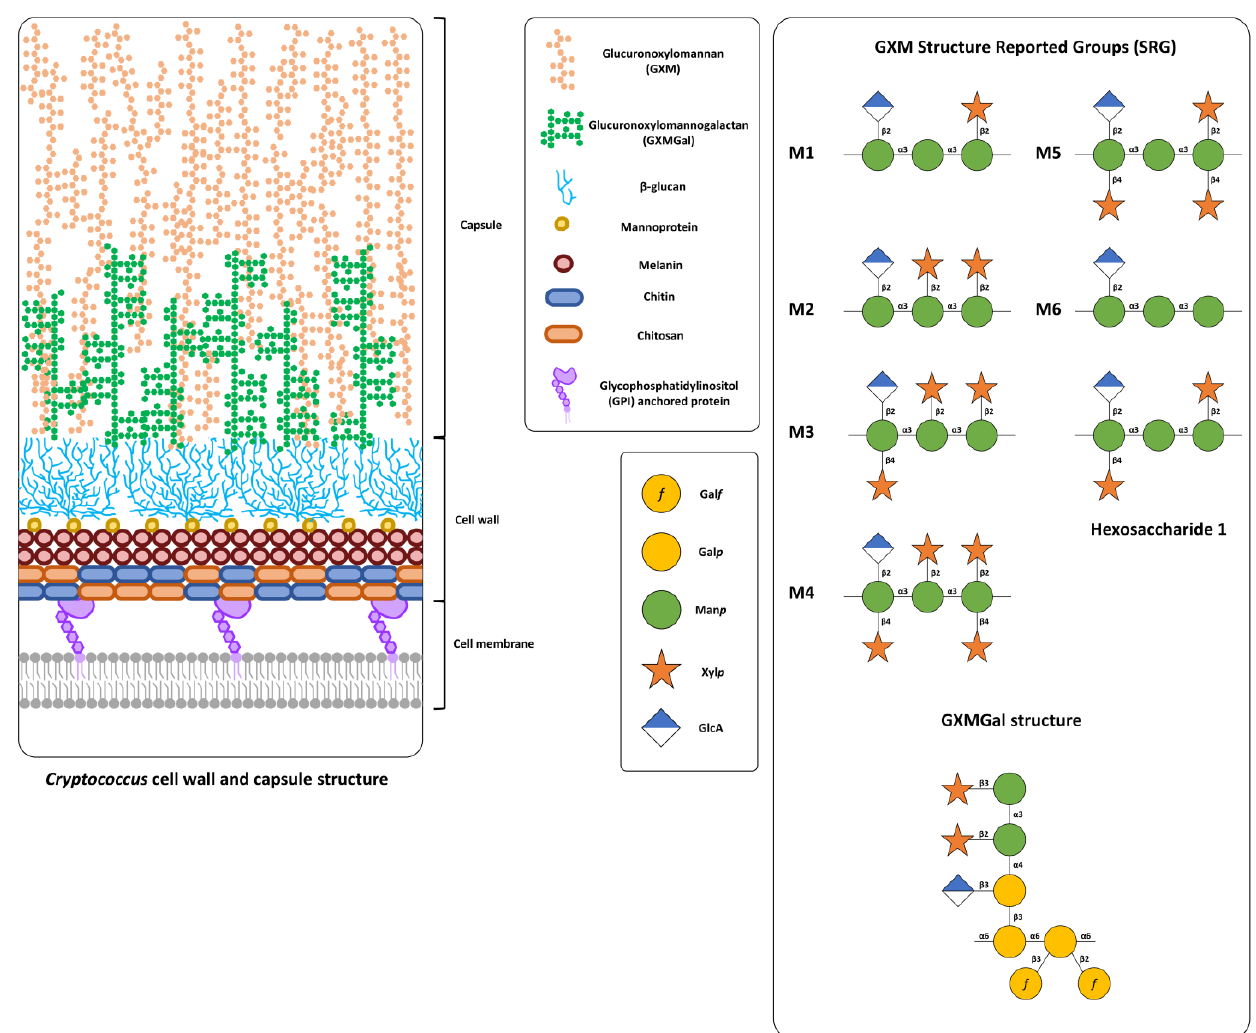
Figure 1. Cell wall and the polysaccharide capsule structure of Cryptococcus spp. with description of the molecular structure of the capsule polysaccharides glucuronoxylomannan (GXM) and glu- curonoxylomannogalactan (GXMGal).